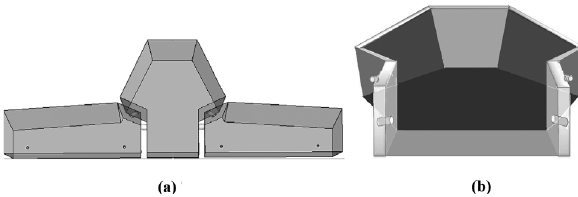
Figure 11: Optimized tundish: (a) tundish structure and (b) porous baffle structure.